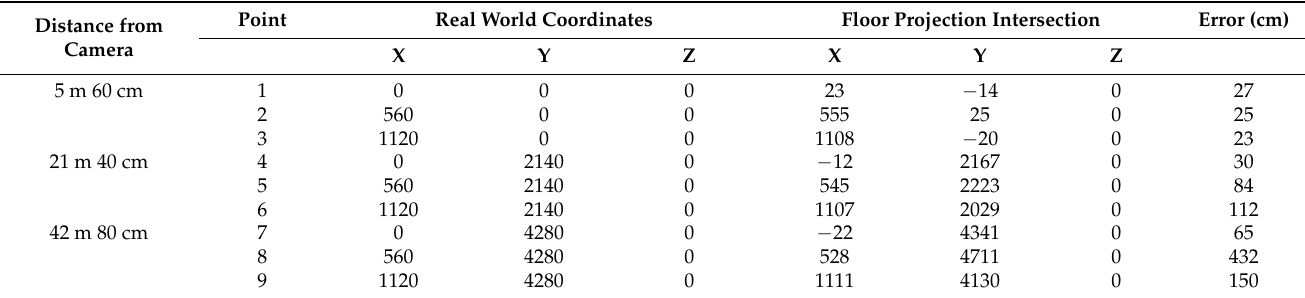
Table 5. Floor projection intersection